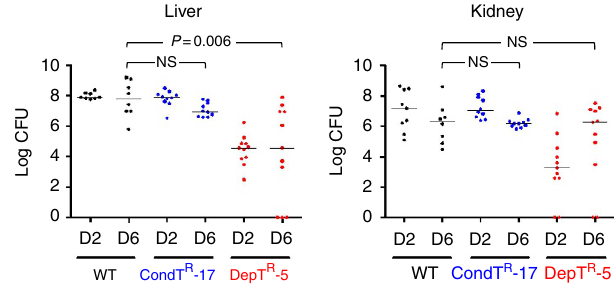
Figure 6 | Infection and persistence of fabD isolates in a mouse model.